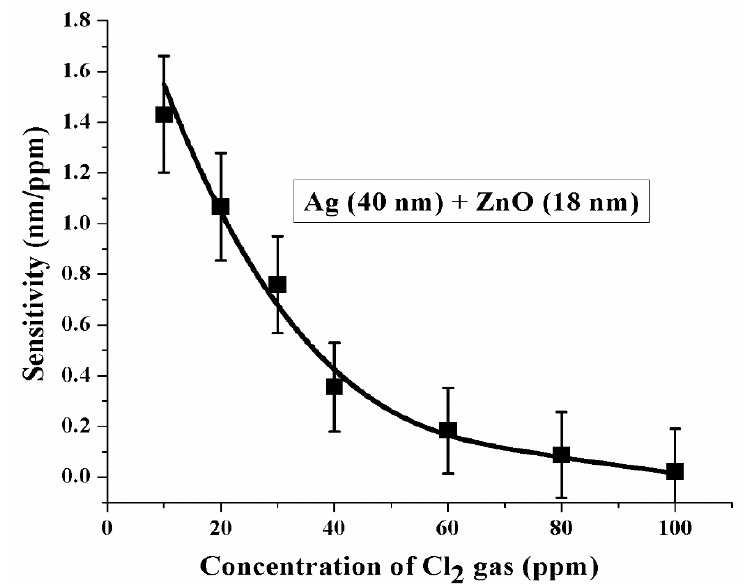
Figure 6. Variation of the sensitivity of the sensor probe with the concentration of the chlorine